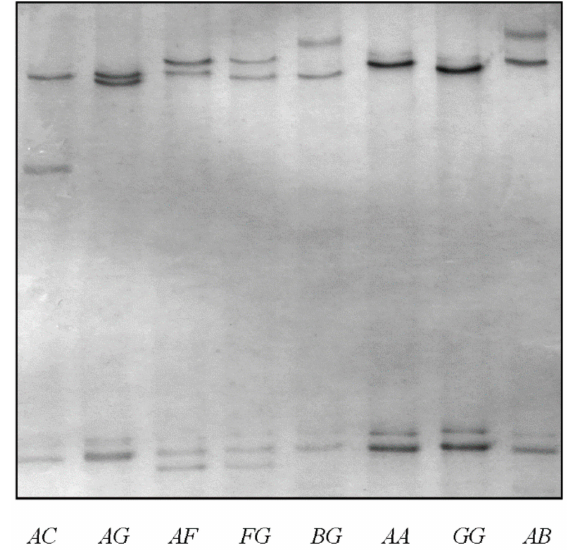
Figure 1. Polymerase chain reaction-single stranded conformational polymorphism (PCR-SSCP) analysis of ovine KRTAP6-3. Five banding patterns, representing five variants ( A , B , C , F, and G ) were identified in either homozygous or heterozygous forms in the sheep